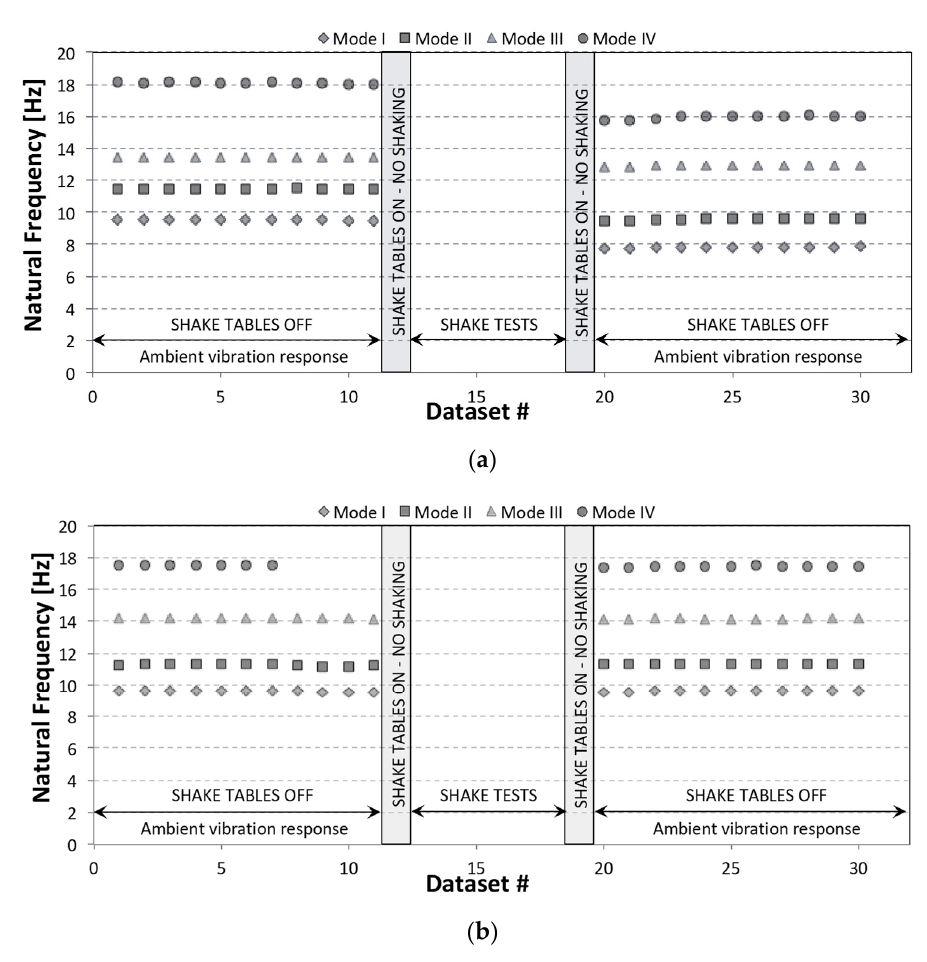
Figure 10. The bridge model: natural frequency time series in the as-built ( a ) and retrofitted ( b ) configuration before and after shaking (adapted from [52]).